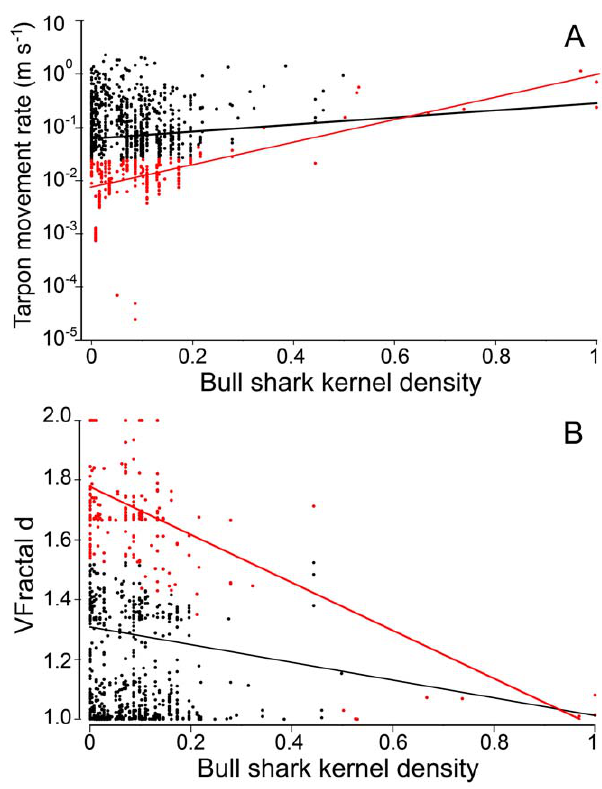
Figure 9. Tarpon movement rate (a) and tarpon track tortuosity ( VFractal d ) (b) as a function of bull shark kernel density. Two analyses were conducted: one with all tarpon data (black and red dots) overlapped with bull shark distribution range; the other with bottom 25% of movement values (red dots in (b)) or top 25% of VFractal d values (red dots in (b)) for each 0.1 bin of bull shark kernel density. The bull shark kernel densities were re-scaled from 0 to 1.0 for low to high density and movement rates were transformed with log10.